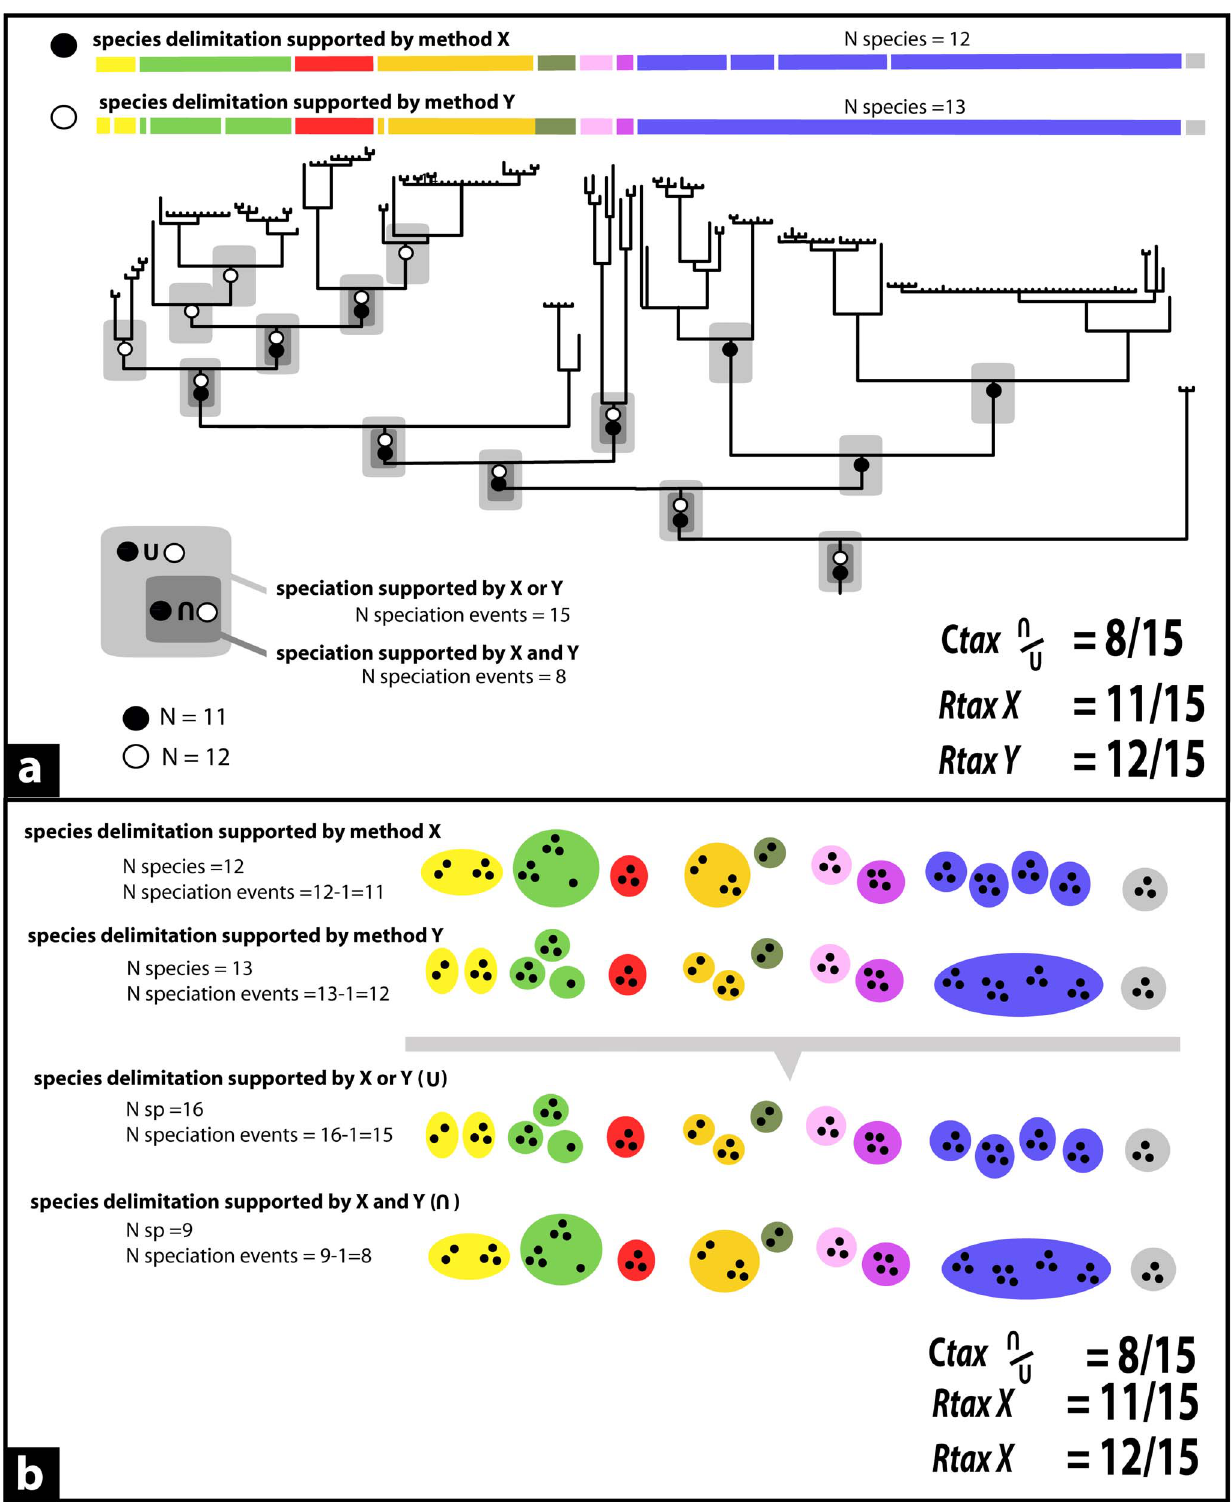
Figure 1. Calculation of the Relative taxonomic resolving power index (R tax ) and Taxonomic index of congruence (C tax ). Calculations are exemplified on two distinct species delimitation approaches (X and Y) supporting different taxonomies. For a better understanding, calculations are first exemplified on a tree-based taxonomy (a). Although these calculations are based on a underlying phylogenetic perspective, knowledge of tree topology is not mandatory to perform the calculations (b). In (a), speciation event hypotheses supported by the approaches X and Y are represented by black and white circles, respectively. The C tax between both approaches is defined as the ratio of the total number of speciation events congruently supported (= shared ) by both approaches (dark grey boxes), relative to the total number of speciation events cumulatively